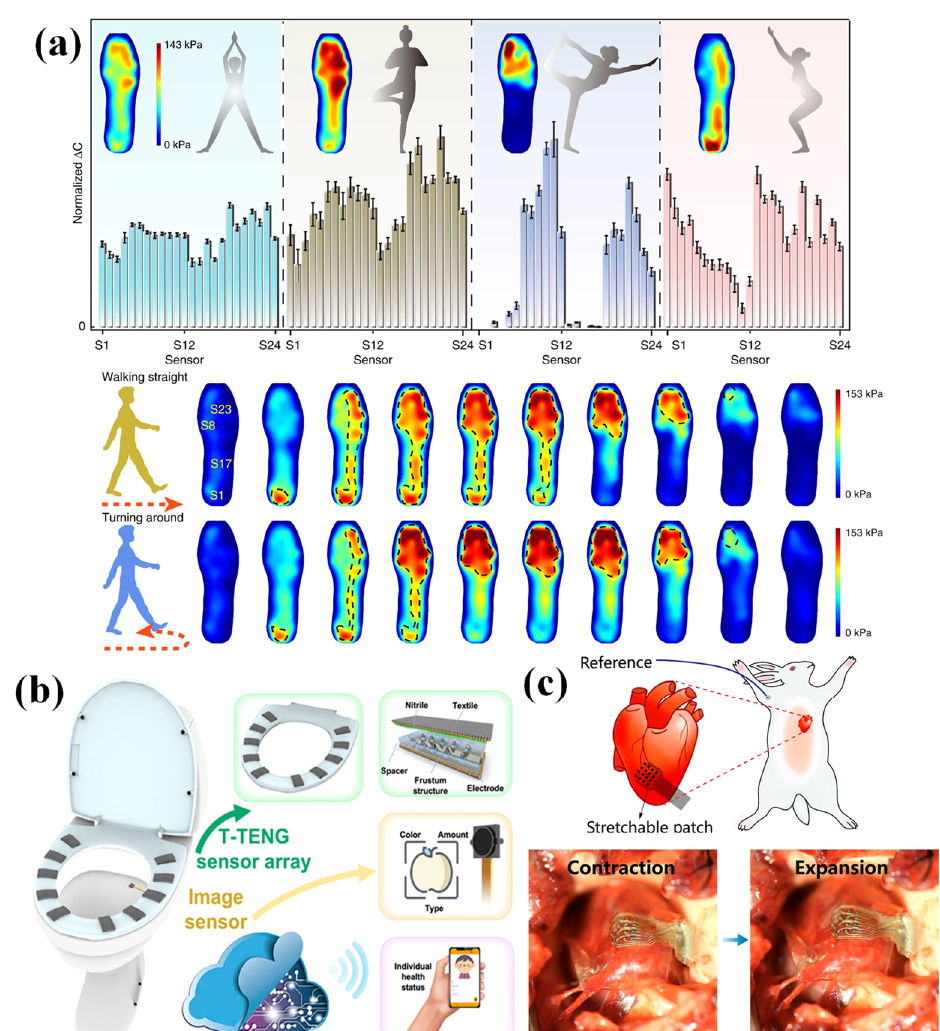
Figure 9. ( a ) Real-time pressure mapping in a smart insole system based on a sensor array. Reproduced with permission from Ref. [115]. Copyright 2020, Juan Tao et al. ( b ) Artificial intelligence toilet (AI-Toilet) for an integrated health monitoring system using smart triboelectric pressure sensor arrays. Reproduced with permission from Ref. [116]. Copyright 2021, Elsevier. ( c ) Intrinsically stretchable electronics with ultrahigh deformability to monitor dynamically moving organs. Reproduced with permission from Ref. [119]. Copyright 2022, Shaolei Wang et al.